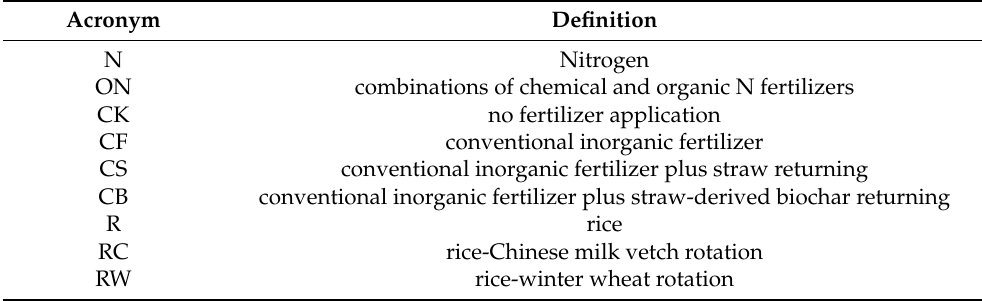
Table 1. Definition of acronyms used in the experimental design in